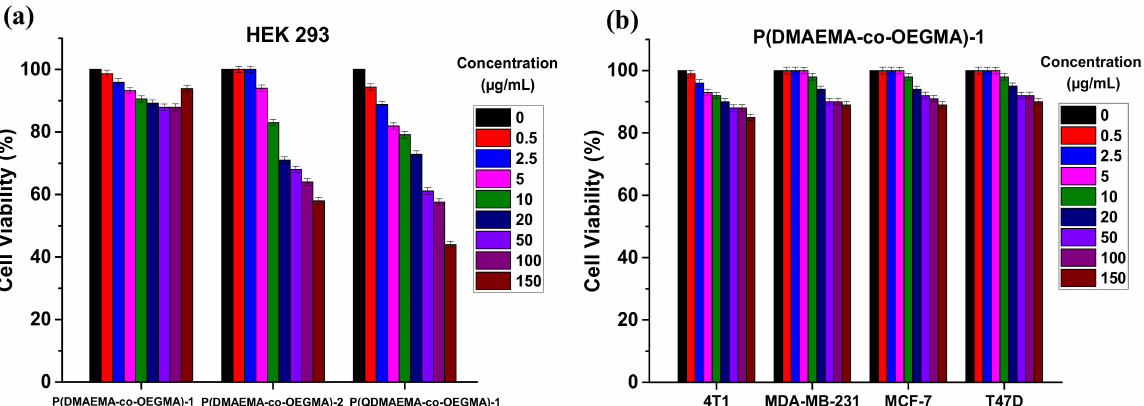
Figure 4. ( a ) MTS cell viability assay after 24 h treatment of HEK293 with various concentrations of P(DMAEMA-co-OEGMA)-1, P(DMAEMA-co-OEGMA)-2, and P(QDMAEMA-co-OEGMA)-1 copoly- mer aggregates. ( b ) MTS cell viability assay after 24 h treatment of 4T1, MDA-MB-231, MC-7, and T47D with various concentrations of P(DMAEMA-co-OEGMA)-1 copolymer aggregates. The concen- tration of 0 µ g/mL corresponds to the untreated cells. Cell viability is expressed as % of cell viability ± SD between two